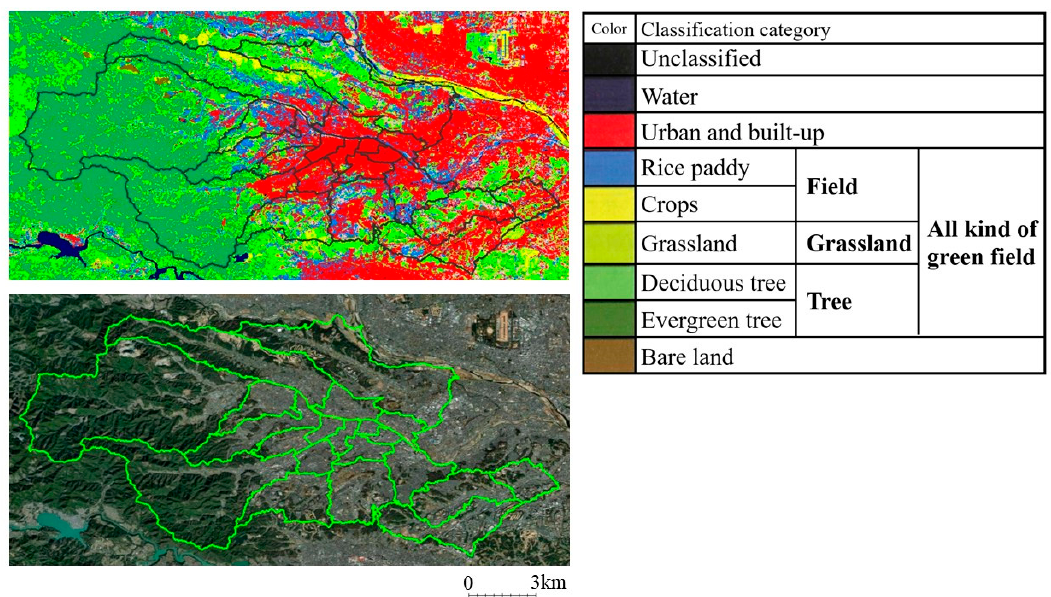
Figure 2. Example of High-Resolution Land-Use and Land-Cover Map (HRM) data and aerial photography of the target area (Hachiouji-city, Tokyo).